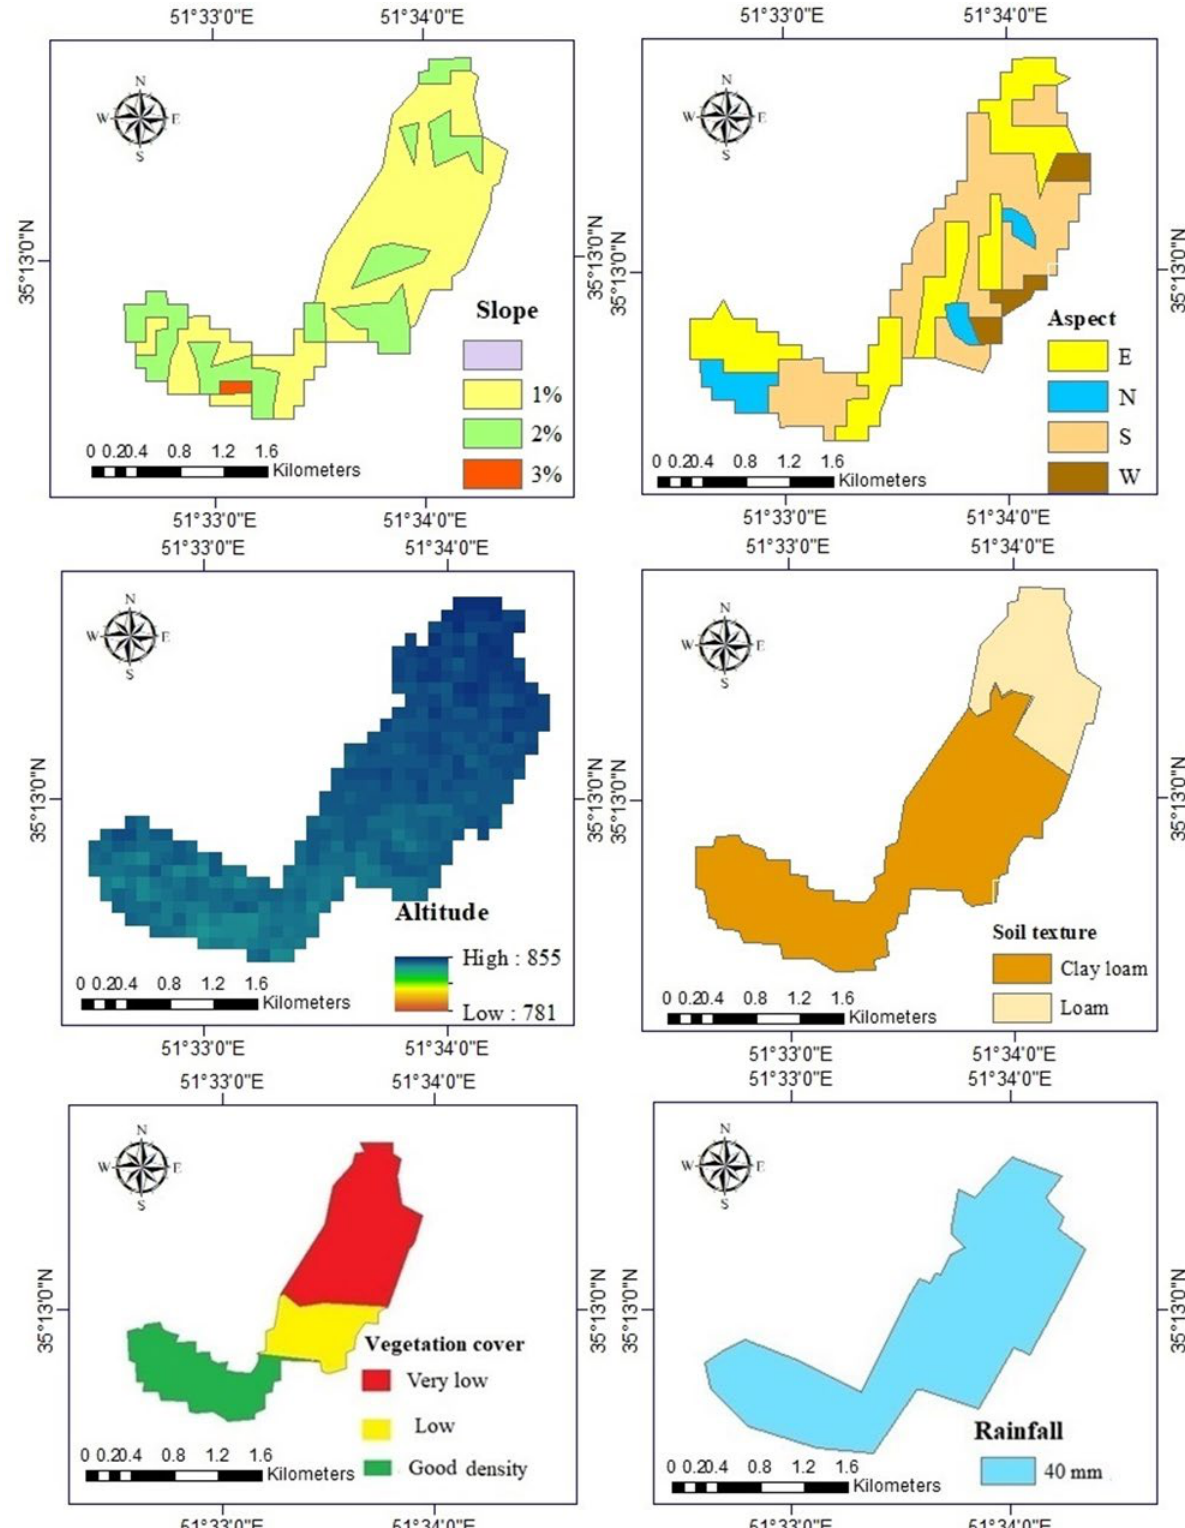
Figure 4. Classification map of ecological factors in Fakhrabad region.